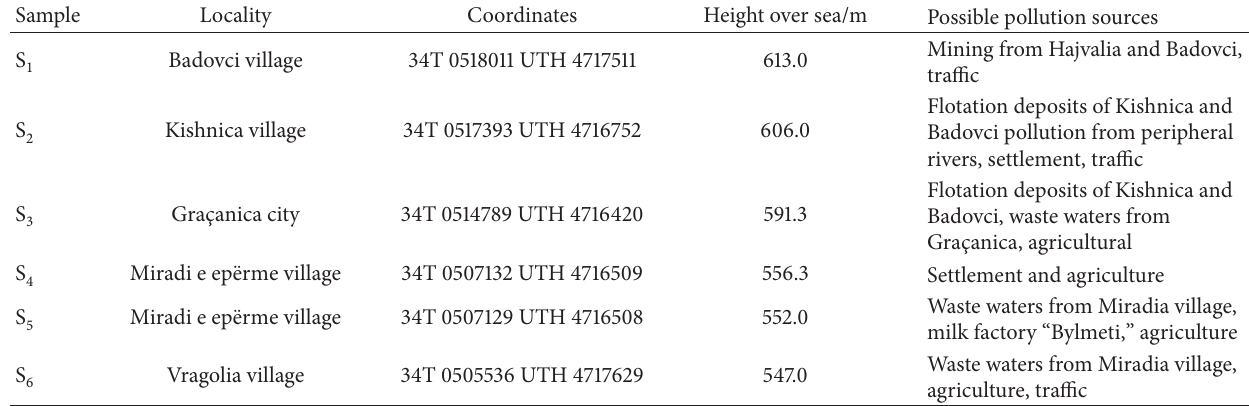
Table 1: Sampling stations with detailed locality description.